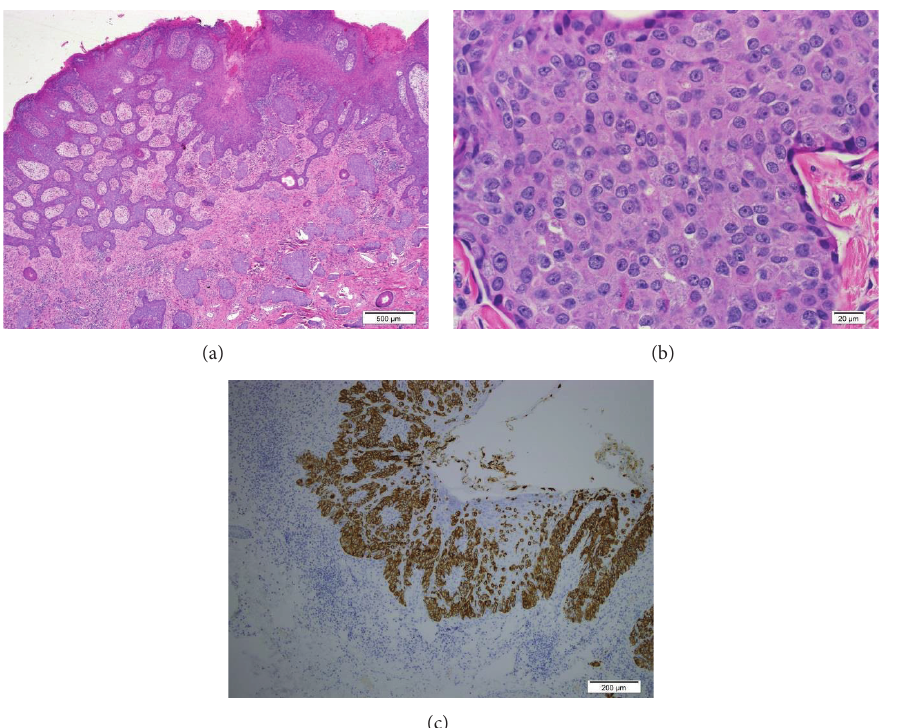
Figure 1: ((a) and (b)) Skin and left scrotum involved by extramammary Paget’s disease with invasive component: (c) cytokeratin 7 highlights adenocarcinoma